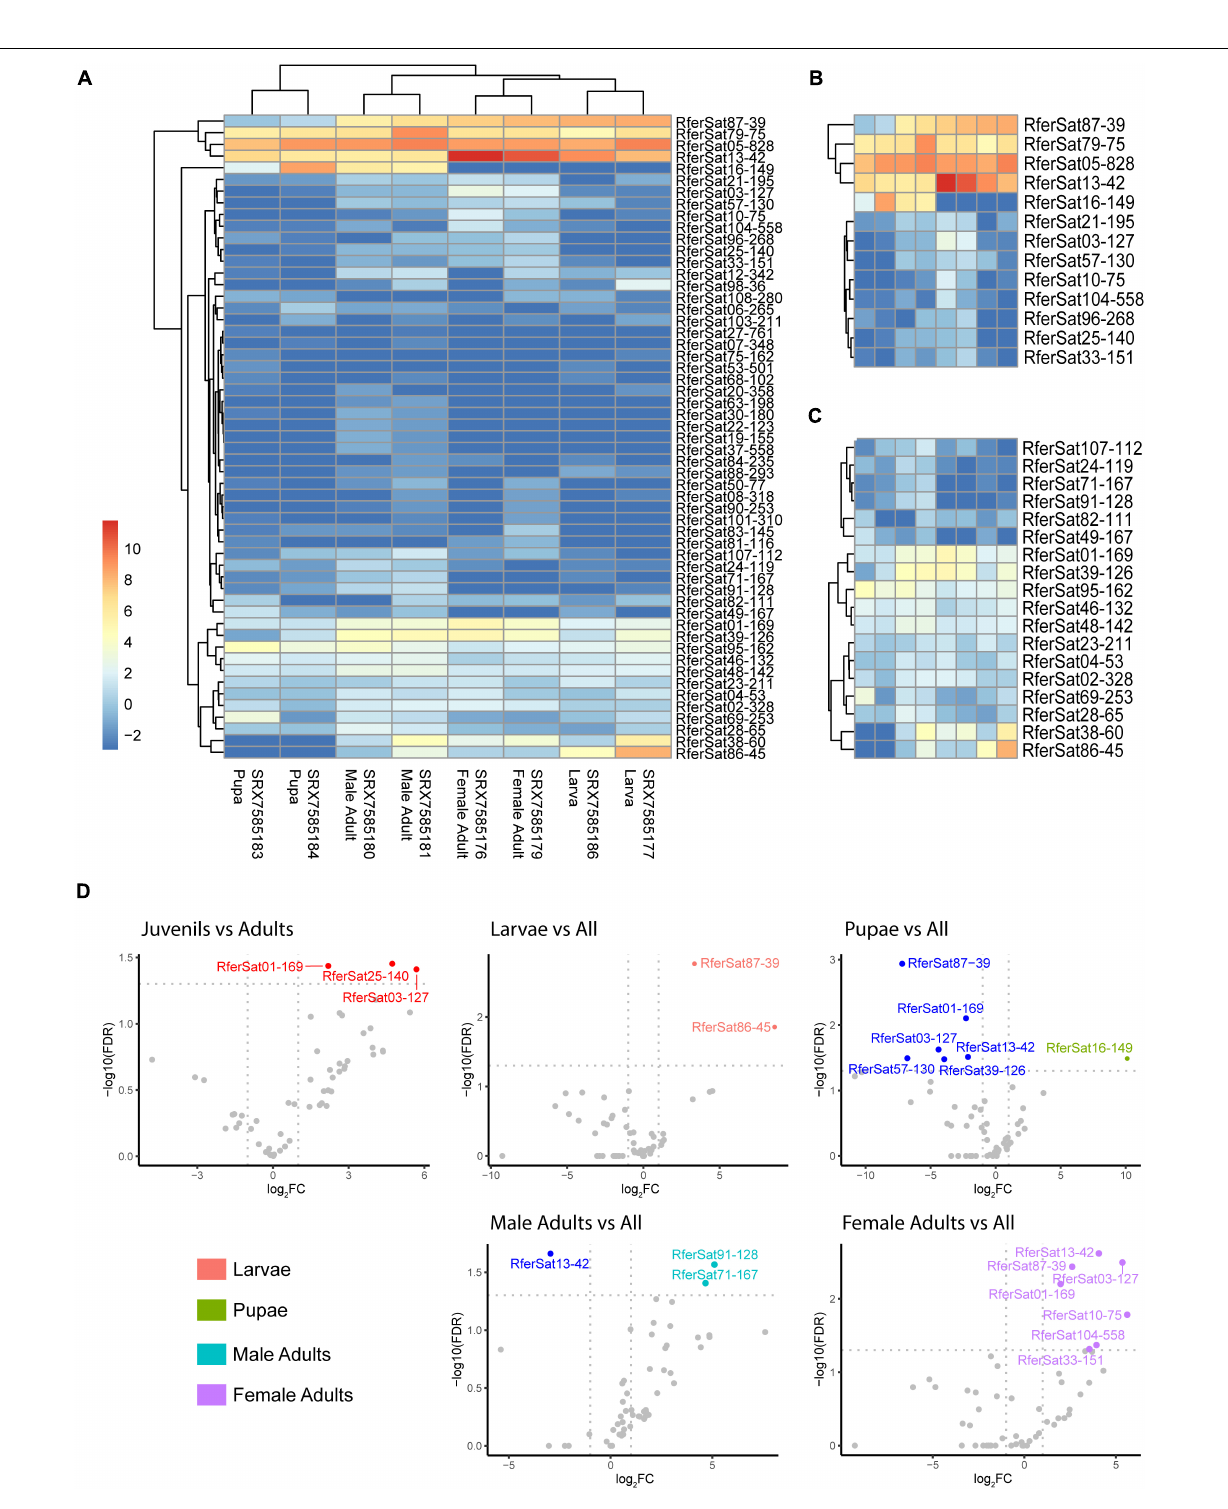
Frontiers in Ecology and Evolution |